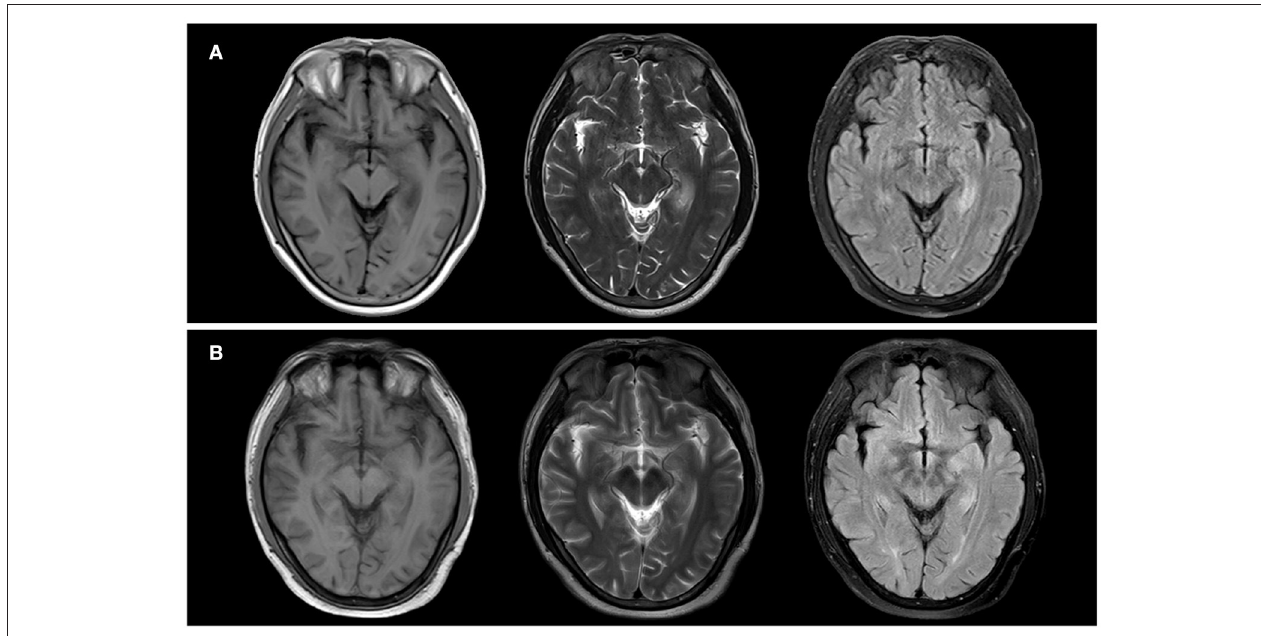
FIGURE 1 | Neuroradiologic MRI (1.5 T) of Patient 1. The bilateral temporal lobes and bilateral hippocampus showed hypointensity on T1WI and hyperintensity on T2WI and FLAIR. Notably, they were more pronounced in the left side (A) . After two months, the bilateral temporal lobes and bilateral hippocampus showed a slightly lower signal on T1WI and a slightly higher signal on T2 and FLAIR. Notably, they were more pronounced in the left side (B)